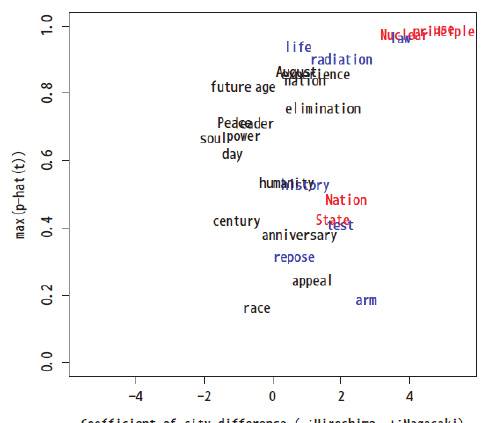
Fig. 24. Scatter plot of keyword's appearance by cluster in